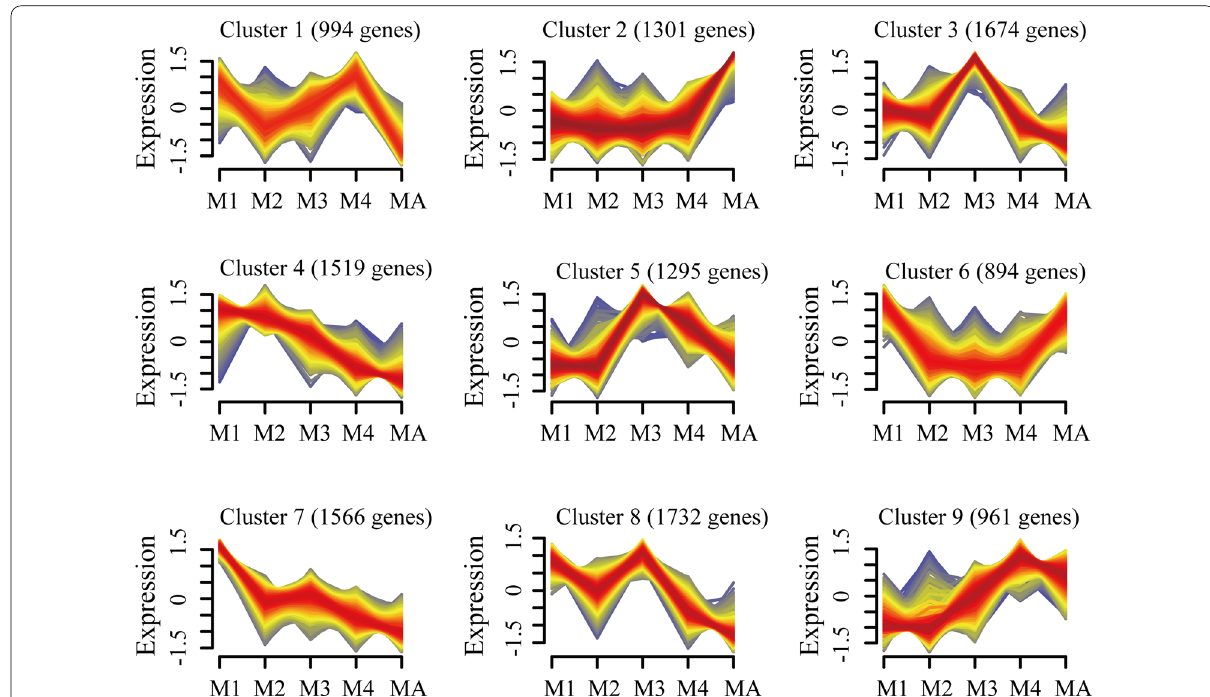
Fig. 5 Gene expression profiles across the development of male. Fuzzy c-means algorithm was implemented to cluster gene expression patterns in all developmental stages of male through Mfuzz software. The 11 936 genes expressed in male cotton aphid were divided into 9 distinct clusters of temporal patterns representing different expression